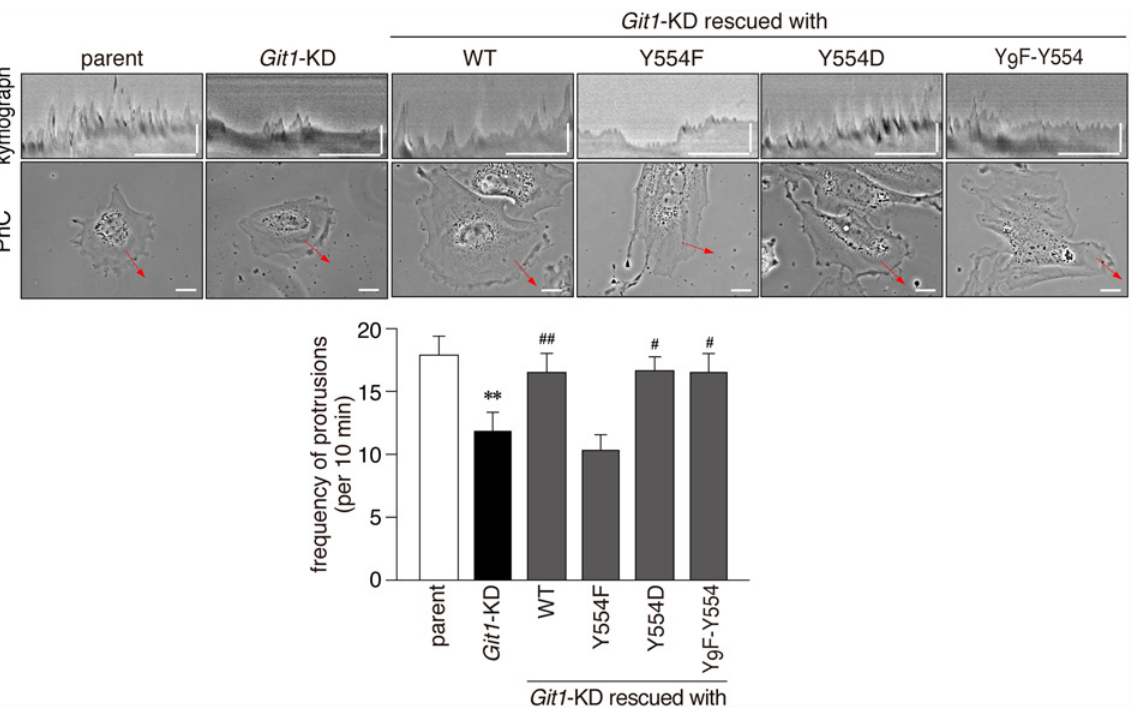
Fig 9. The phosphorylation-defective Tyr-554 mutant of Git1 failed to restore impaired lamellipodial protrusion activity in A7r5 cells by Git1 - knockdown. Representative kymographs (upper pictures; scale bars, 10 min on the x-axis and 10 μ m on the y-axis) obtained from phase-contrast photographs (lower pictures; scale bars, 20 μ m) of parental cells, Git1 -KD cells, and Git1 -KD cells expressing various mCherry-fused Git1 proteins on fibronectin-coated dishes. Before beginning the recording, the expression of mCherry-fused proteins was verified in the rescue experiments by a short exposure to UV to avoid possible cell damage. The lower graphs show the frequency of protrusions. Data are the mean ± S.E. (error bars; n = 10 to 11 each). ** , P < 0.01 significantly different from parental cells; # , P < 0.05 or ## , P < 0.01 significantly different from Git1 -KD cells by ANOVA and Scheffé ’ s post hoc